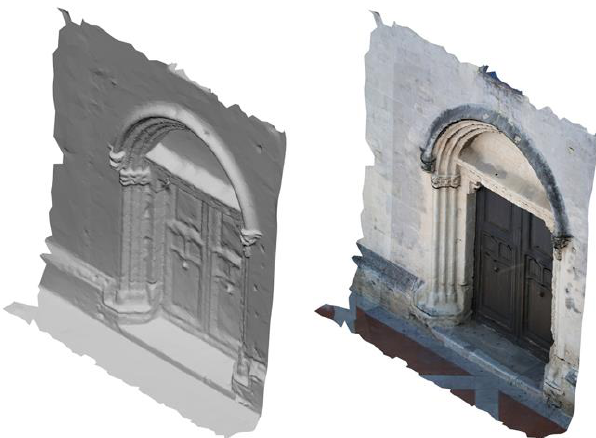
Figure 7. Model of the portal of San Pietro in Assemini, obtained with Autodesk 123D